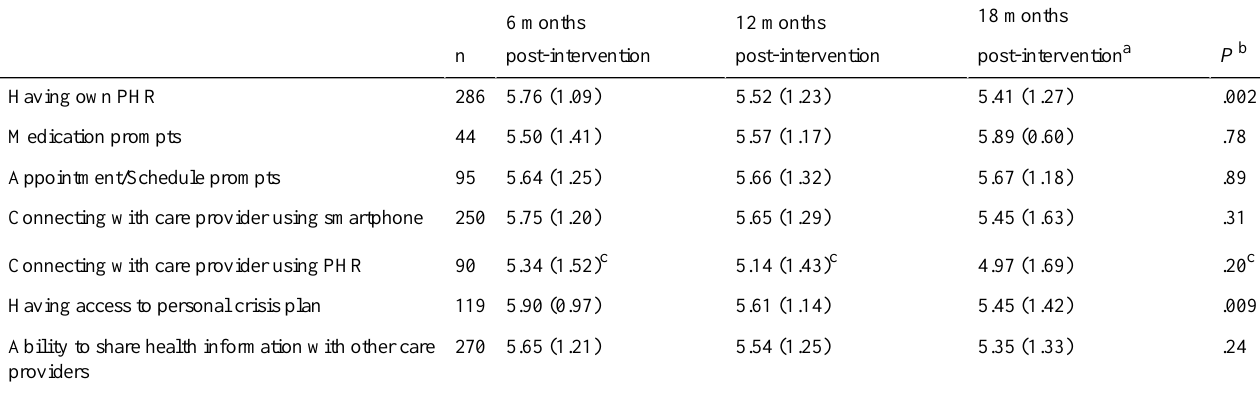
Table 4. Scores for perceptions about specific functions of the smartphone and Lawson SMART Record over